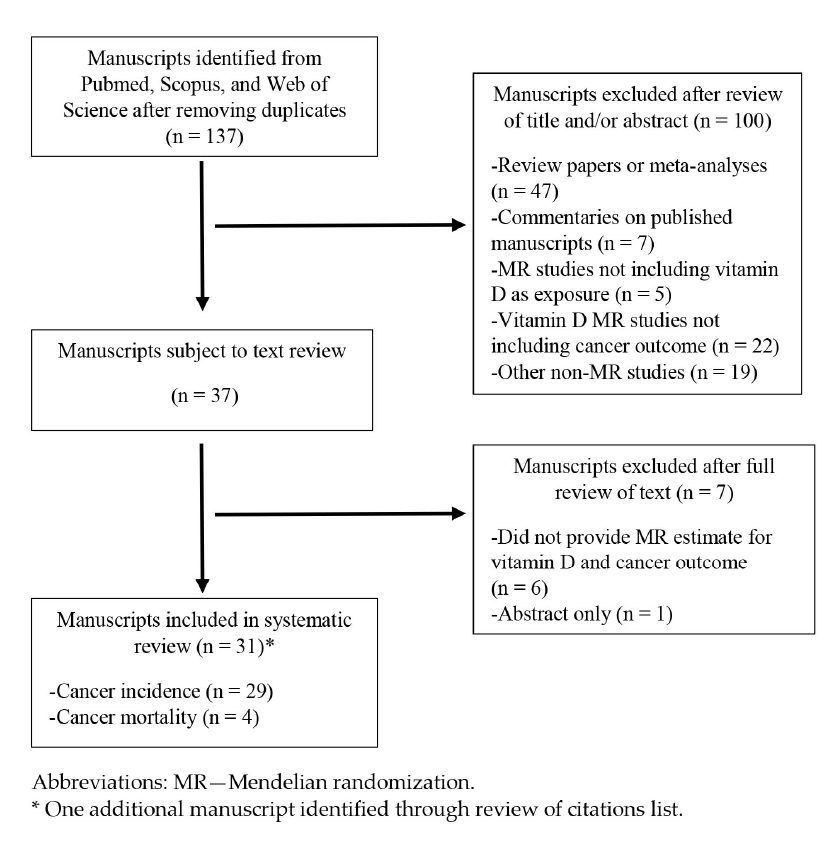
Figure 2. Flow diagram of studies included in systematic review.